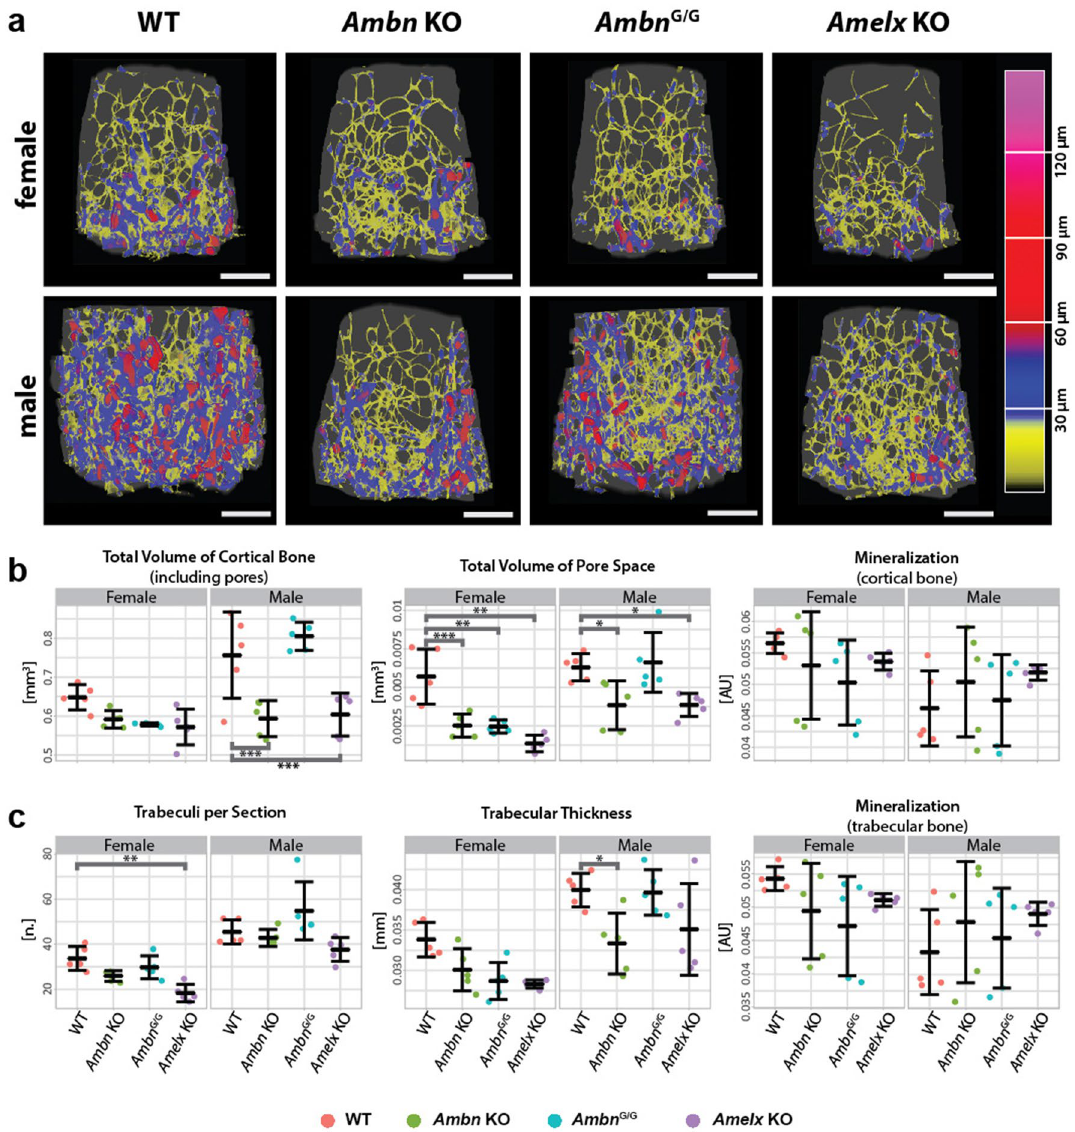
Figure 4. Bone ultrastructure is affected in Ambn and AmelX KO. ( a ) Trabecular structure. Pseudocolors correspond to trabecular thickness (spectrum on the right). Bar = 0.5 mm. Specimens closest to group’s average selected. ( b ) Whisker plots of femoral cortical bone microstructure: total volume of cortical bone (including pores), total volume of pore space, both in mm3, and mineralization of cortical bone in Attenuation units (AU). ( c ) Whisker plot of femoral trabecular bone: mean number of trabeculae per section, the mean thickness of trabeculae in mm, and mineralization of trabecular bone in AU. Females on the left and males on the right of each graph. Thick midline = mean, whiskers = standard deviation; * < 0.05; ** < 0.01, *** < 0.001. Values for each observation are shown as points—WTs in red, Ambn KO in green, Ambn G/G in blue, and Amelx KO in